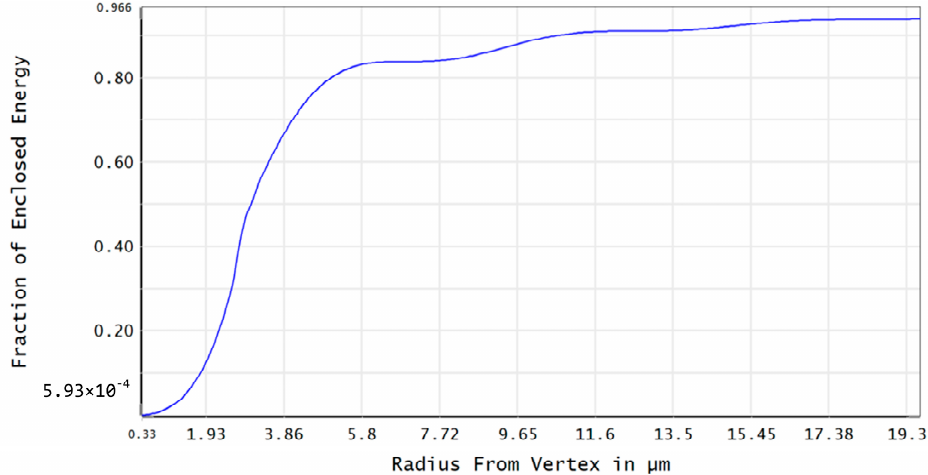
Figure 11. Plot showing the diffraction encircled energy of the optical system.